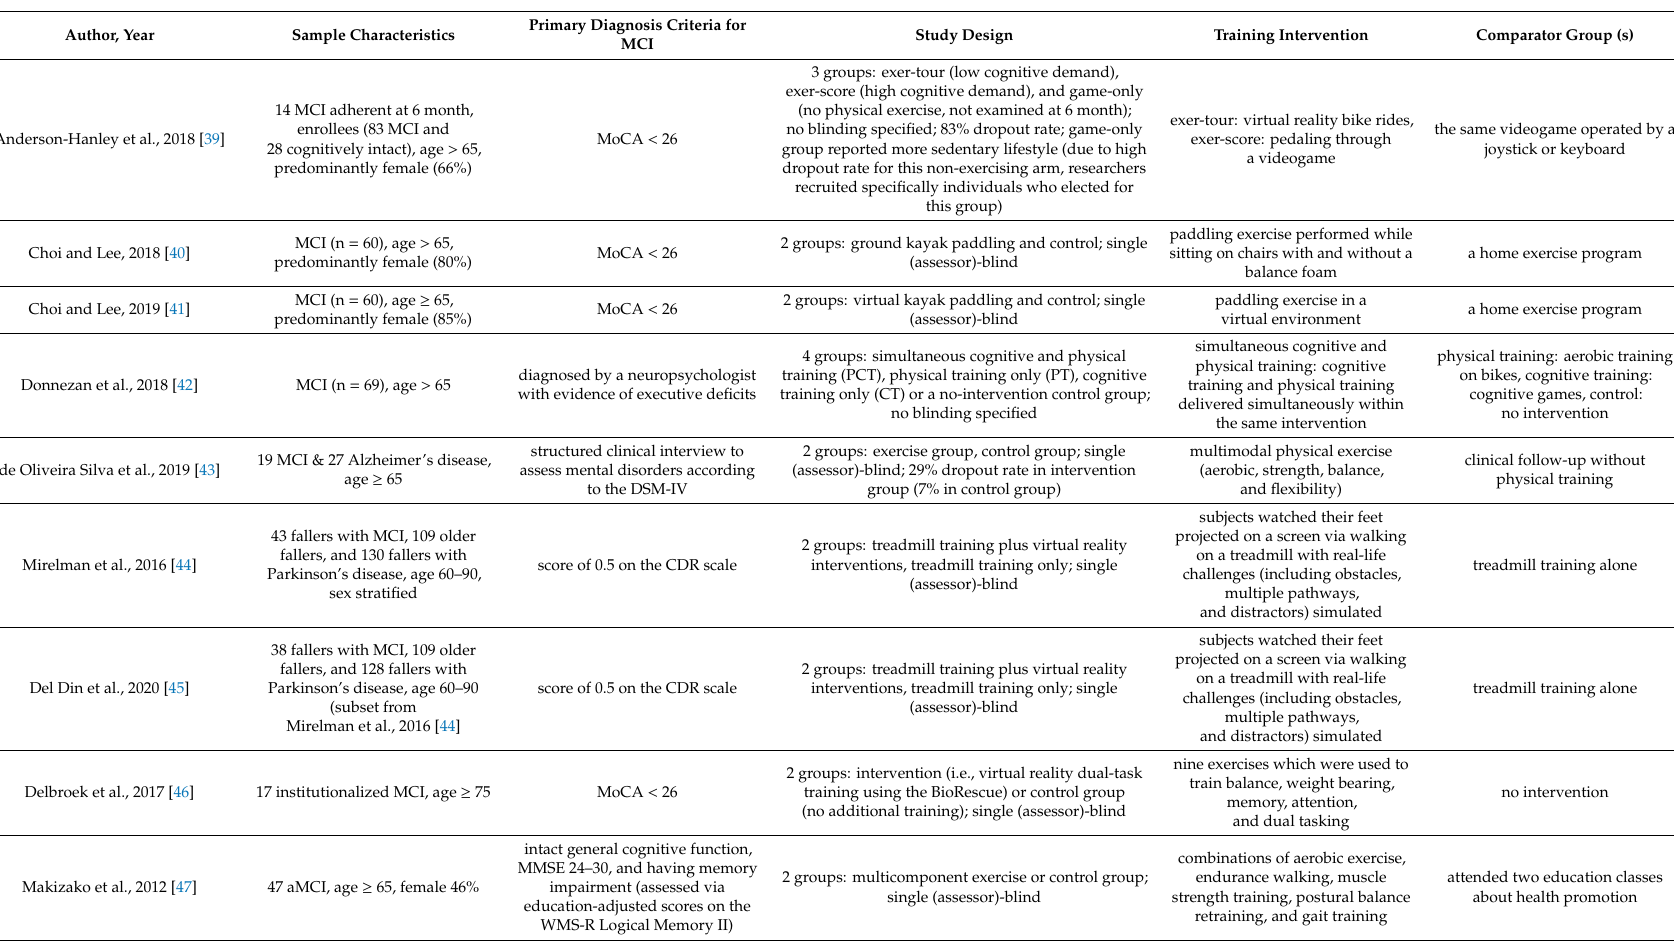
Table 1. Sample characteristics, diagnosis, study design, and intervention paradigms in the RCTs included. Abbreviations: MCI mild cognitive impairment; MoCA Montreal cognitive assessment; DSM-IV diagnostic and statistical manual of mental disorders, fourth edition; CDR clinical dementia rating; MMSE mini-mental state examination; WMS-R Wechsler memory scale-revised; ICD-9-CM international classification of diseases, ninth revision, clinical modification; ACE Addenbrooke’s cognitive examination; ADL activities of daily